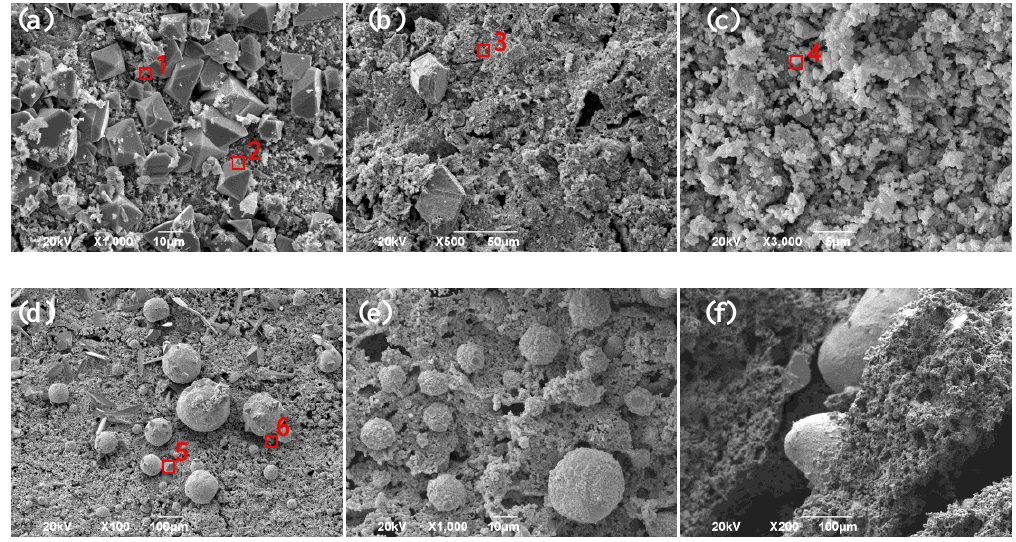
Figure 5. SEM images of the roasted products at different temperatures: ( a ) 500 °C; ( b ) 600 °C; ( c ) 700 °C; ( d ) 800 °C; ( e ) 900 °C; and ( f ) 1000 °C.